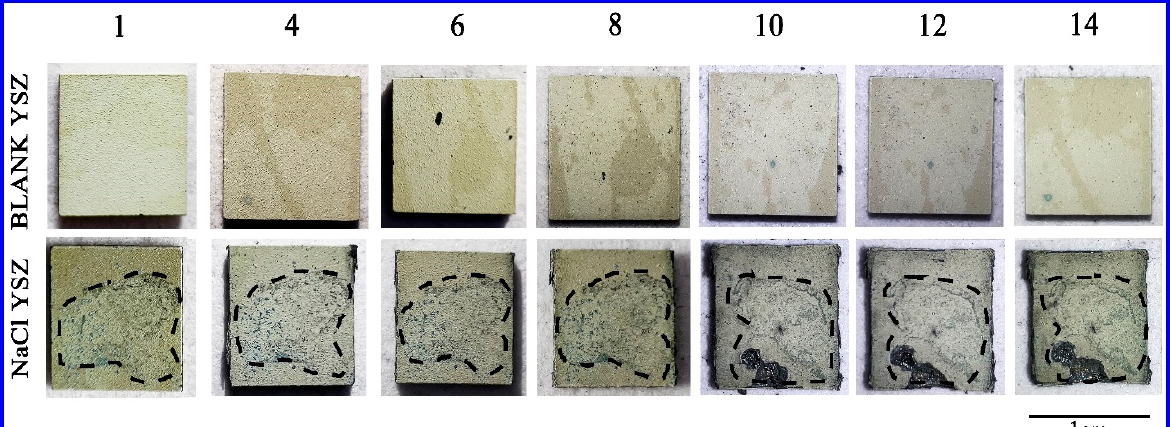
Figure 4. Selected visual images showing the top surface of YSZ coating after different numbers of corrosion test cycles. 1–14 represents the number of corrosion cycles. The salt-corroded region is approximately marked using a black dashed line.